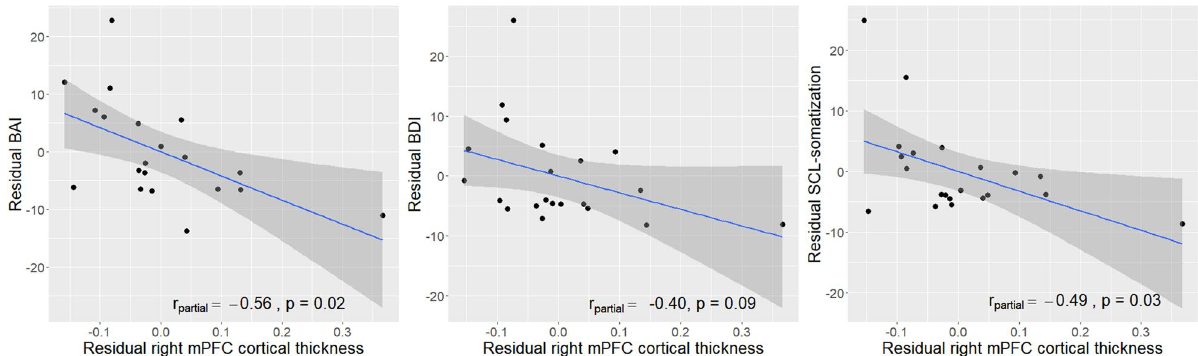
Figure 2. Negative correlations between psychiatric symptom scores and the cortical thickness of the right mPFC cluster in the trauma-exposed control group after adjusting for age and sex. mPFC medial prefrontal cortex, BAI beck anxiety inventory, BDI beck depression inventory, SCL-somatization somatization subscale of Symptom